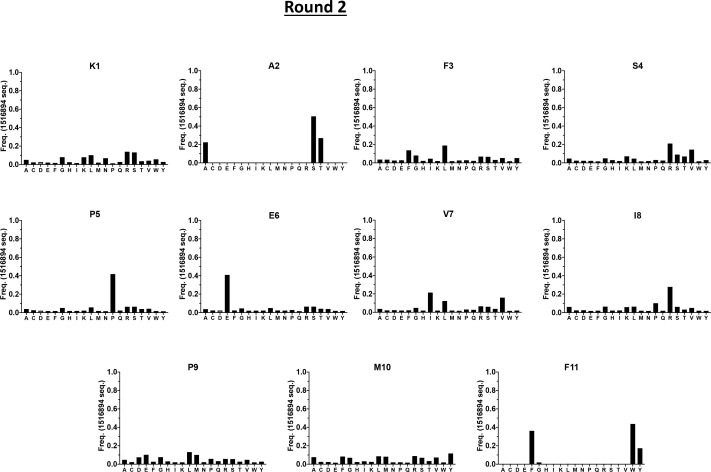
Individual amino acid frequencies of the AGA1 TCR-selected, HLA-B*57:03-restricted yeast display peptide repertoire following Round 2 selection.Individual amino acid frequencies along the length of the 11 amino acid peptide are illustrated in bar chart format, with the frequencies of peptide sequence reads represented on the Y axis. Individual amino acids at each position of the 11mer peptide are represented on the X-axis. K1, A2, F3 refers to amino acid positions 1, 2, 3, etc, of the HIV KF11 peptide sequence, which is included for reference.
Figure 2—figure supplement 3—source data 1.Amino acid signatures of Yeast display libraries-AGA1 TCR Round 2 selection.